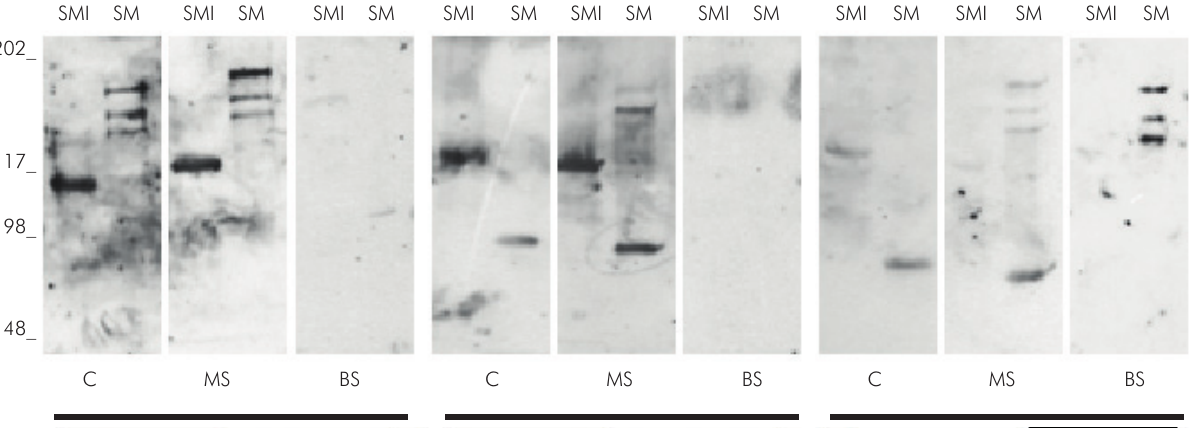
Figure 3. Patterns of IgA specificities against antigens from SMI ( Streptococcus mitis ) and SM ( S. mutans ) in C (colostrum), MS (maternal saliva) and BS (newborn saliva) in the 3 groups of samples. Standard molecular sizes (kDa) are indicated in left the